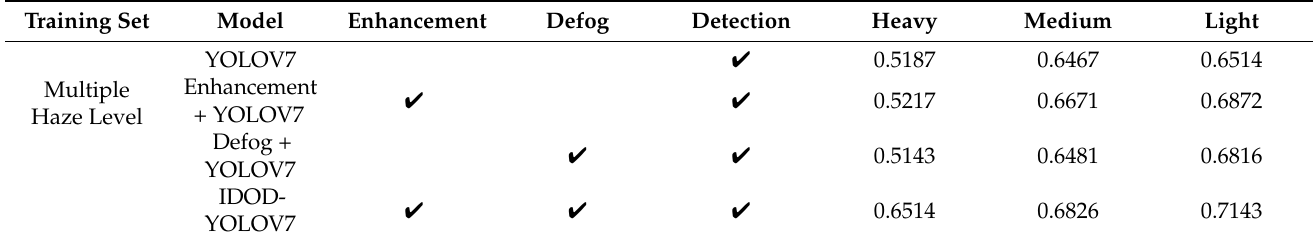
Table 5. Ablation analysis on the low-light foggy in Image Dehazing Model